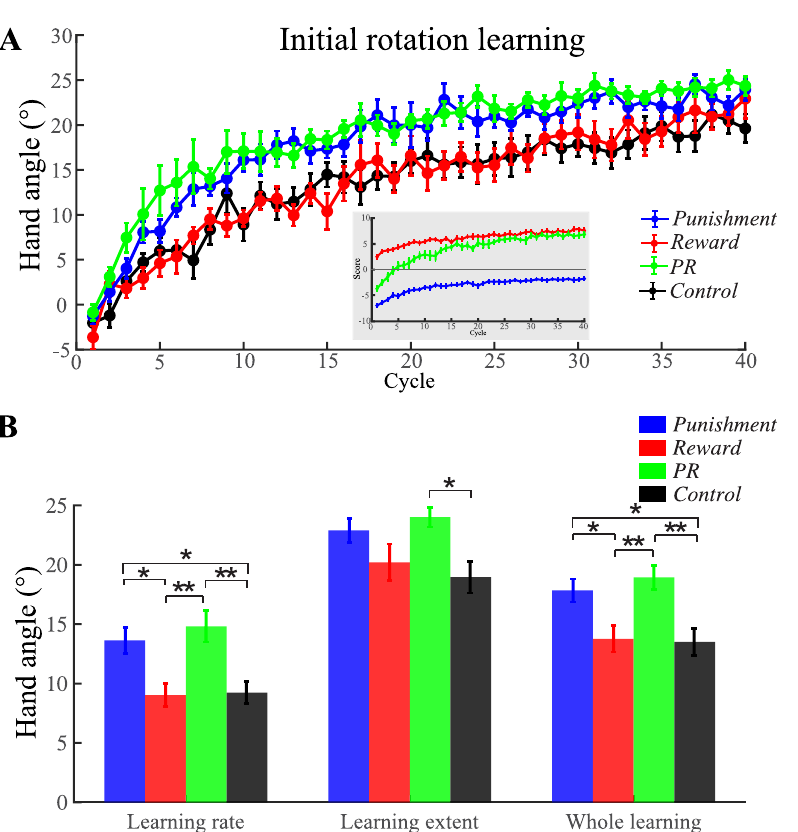
Fig 3. Comparison of the learning during the initial rotation learning phase from four different groups. A) The learning curves during the initial rotation learning phase of the four groups. Inset illustrates the score curves for the three motivational groups. B) Average learning rate, average learning extent, and average hand movement direction of the whole learning cycles of each group. Positive angle denotes CW direction. Error bars denote SEM. * p < 0.05, ** p <